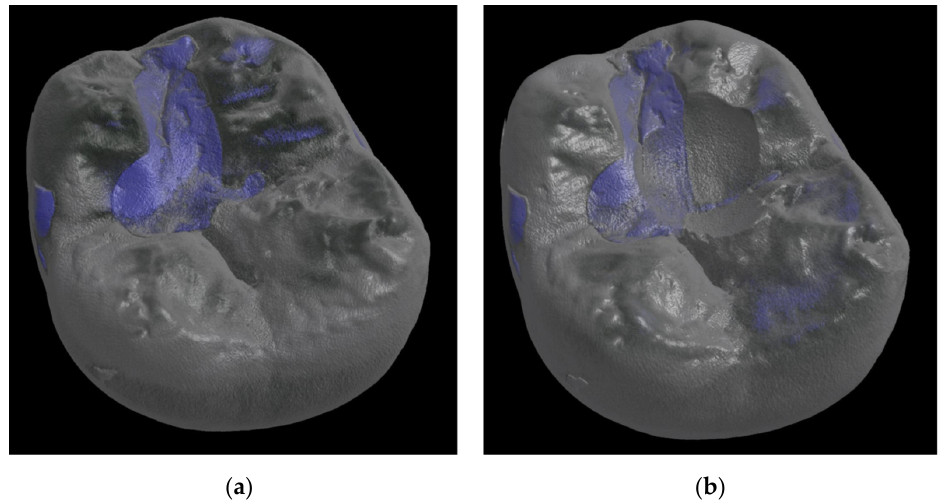
Figure 2. Reconstructed µCT images of a restored tooth to calculate the abrasion volume (DeltaFil— Specimen 8). The µCT images were recorded prior to the chewing simulation ( a ) and after completion of the chewing simulation at 1,200,000 cycles ( b ).